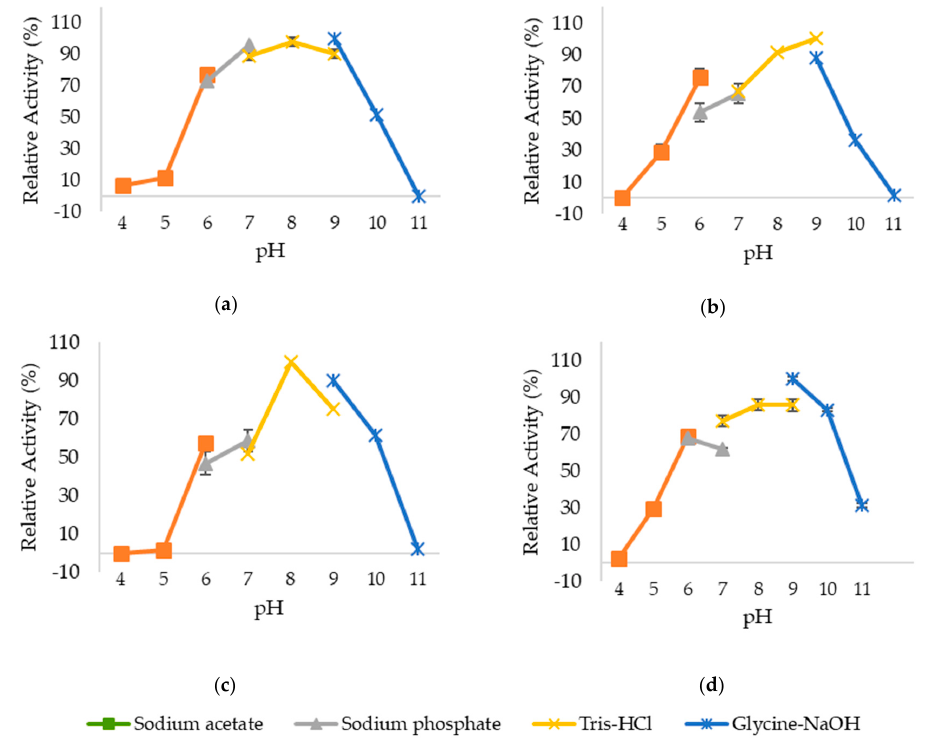
Figure 4. Optimum pH and stability of lipases in different pH values in buffer systems as follow; Sodium acetate buffer (pH 4–6), Sodium phosphate buffer (pH 6–7), Tris-HCl (pH 7–9) and Glycine-NaOH (pH 9–11). Sodium acetate buffer (pH 4–6), Sodium phosphate buffer (pH 6–7),